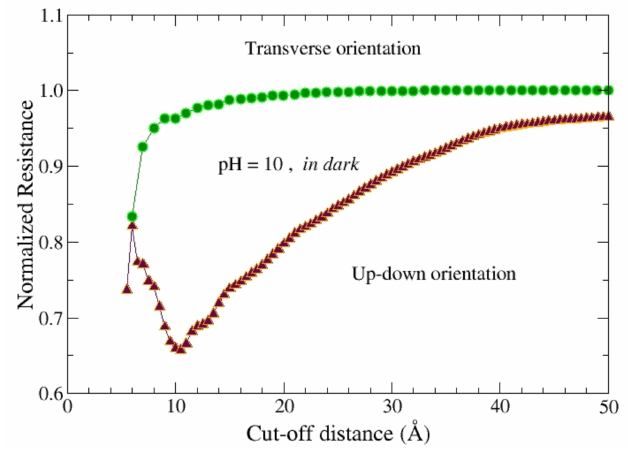
Figure 3. The normalized -resistance R (#)/R of b RC at pH = 10, as a function of the cut-off distance D . Data are obtained using different contact orientations: the up-down in which the protein is assumed to be with the chain H (but helix 1) on the electrode (see Figure 1a), and the transverse one in which the protein lays on its back on the electrode (see Figure 1b). Data refer to structures in dark.